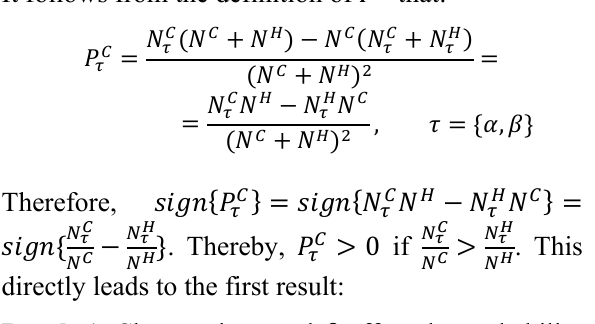
Result 2. The worsening of environmental conditions leads to a smaller probability of conservation,